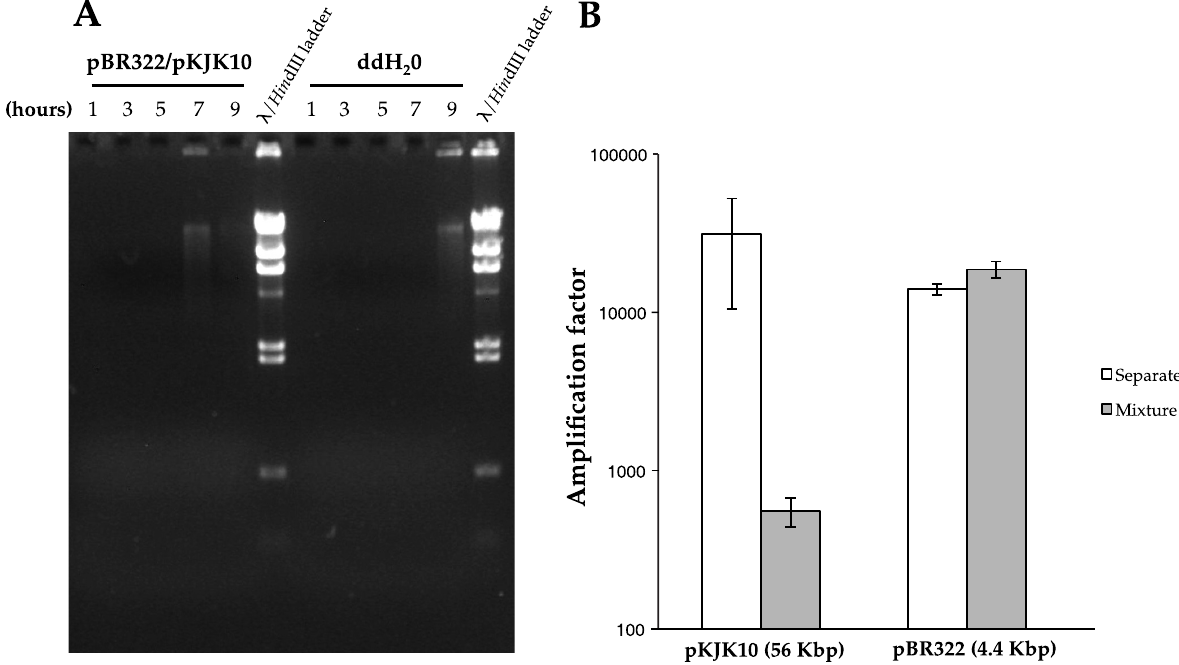
Figure 1. Optimization (a) of multiple displacement amplification (MDA) incubation time, and (b) measured fold-amplification of plasmids pBR322 (4.4 Kbp) or pKJK10 (56 Kbp), following 7 hours of MDA. The two plasmids were mixed in equal concentration ( , 0.2 ng/ m L) and subjected to plasmid-safe exonuclease digestion for 48 hours, followed by MDA for 1, 3, 5, 7 or 9 hours. MDA products were visualized on 1% agarose to estimate the longest possible MDA incubation time (panel a, left lanes) that did not lead to generation of template-independent products (panel a, right lanes). Quantitative PCR (qPCR) was used to quantify copies of pBR322 and pKJK10 before and after 7 hours of MDA, which was performed on plasmids in separate reactions as well in mixture. Error bars represent standard deviations of three independent replicates.